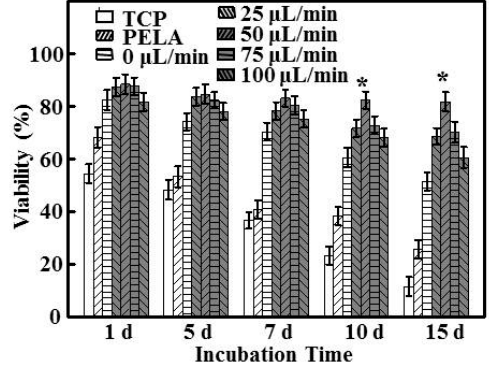
Figure 2. The viability of hepatocytes cultured under different flow rates for 1, 5, 7, 10, and 15 days ( n = 5, * p < 0.05) compared with those cultured on Poly(ethylene glycol)-poly( DL -lactide) (PELA) and tissue culture plates (TCPs).